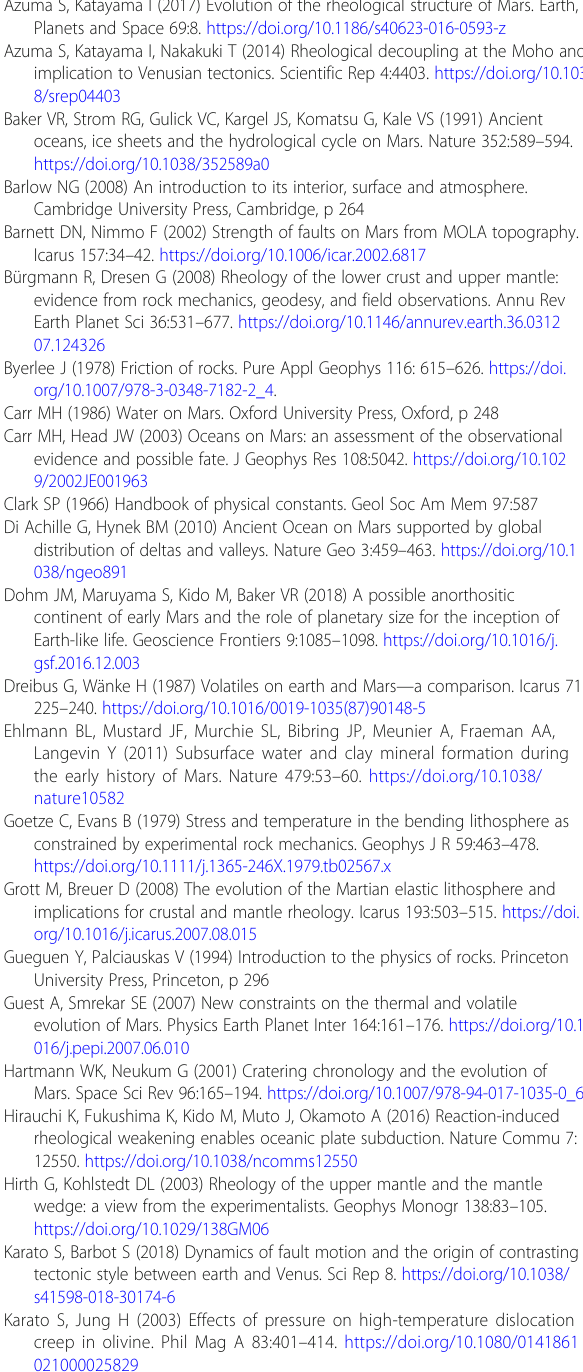
Additional file 1: Figure S1. Rheological structures at additional locations calculated under dry conditions. Plastic strength was calculated using a strain-rate of 10 -19 s -1 . (PDF 837 kb) Additional file 2: Figure S2. Rheological structures at additional locations calculated under wet conditions. Plastic strength was calculated using a strain-rate of 10 -19 s -1 . (PDF 781